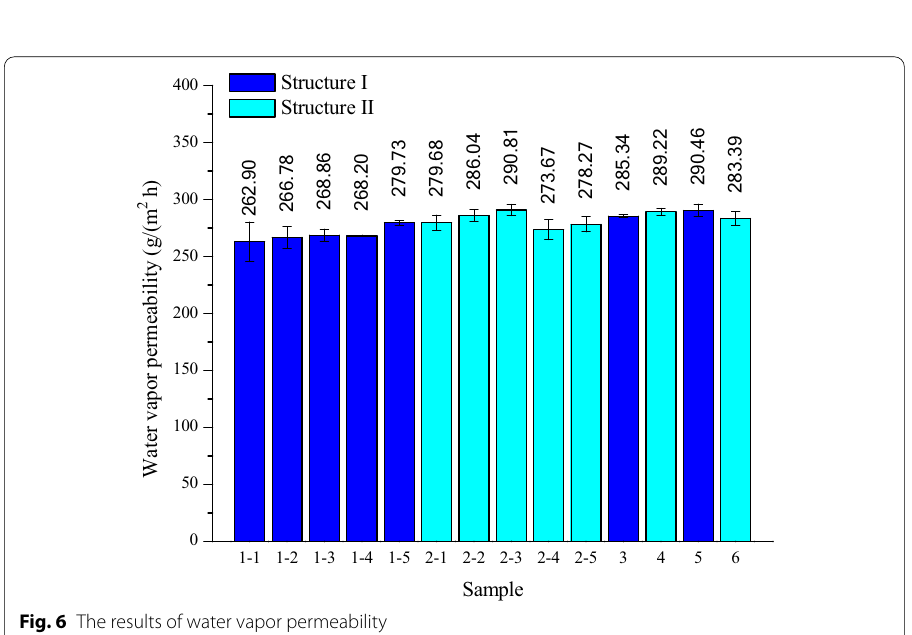
Fig. 6 The results of water vapor